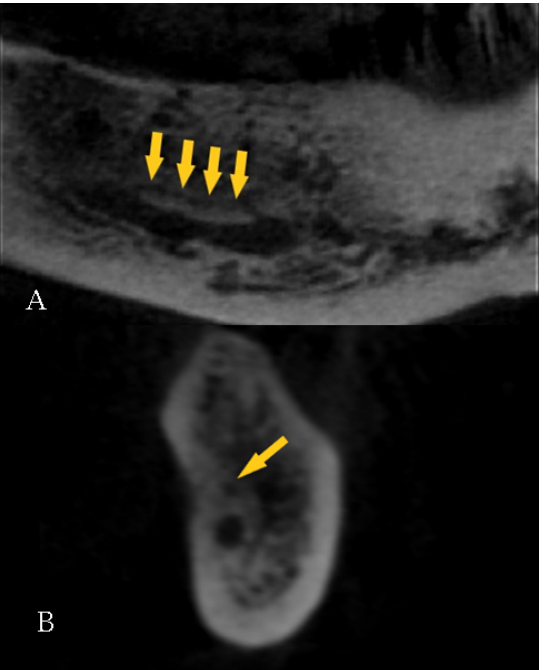
Figure 7. Type 3, confluent anterior canal: ( A ) Panorex and ( B ) cross-section reconstructions. Arrows indicate the presence of the canal.